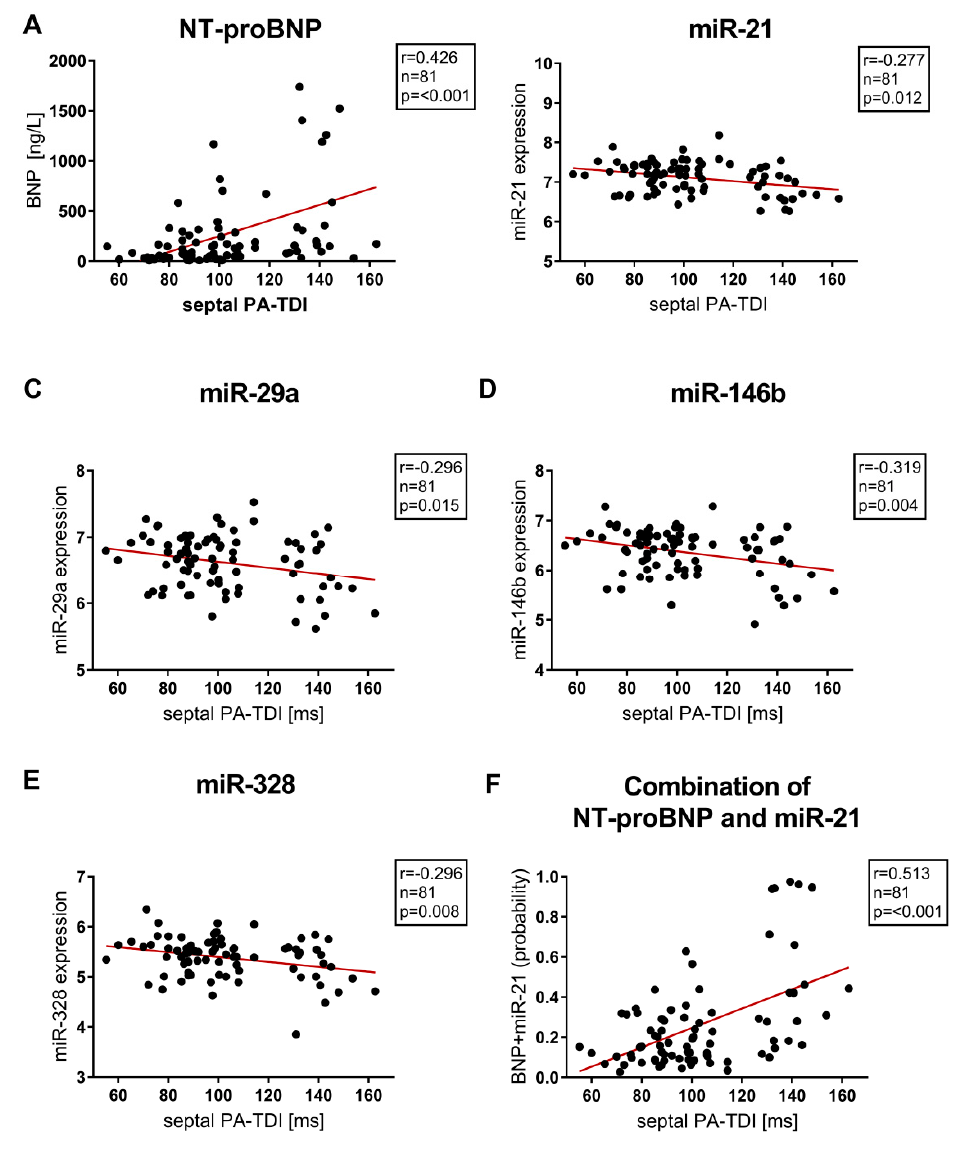
Figure 4. Correlation between septal PA-TDI, NT-proBNP, single micro RNAs (miR − 21, miR − 29a, miR − 146b, miR − 328) and combined miR − 21 and NT-proBNP to distinguish between patients with and without AF. A : NT-proBNP, B : miR − 21, C : miR − 29a, D : miR − 146b, E : miR − 328, F : Combination of NT-proBNP and miR − 21 (probability) miR- Micro ribonucleic acid, NT-proBNP- N-terminal pro-brain natriuretic peptide, septal PA-TDI- septal total atrial conduction